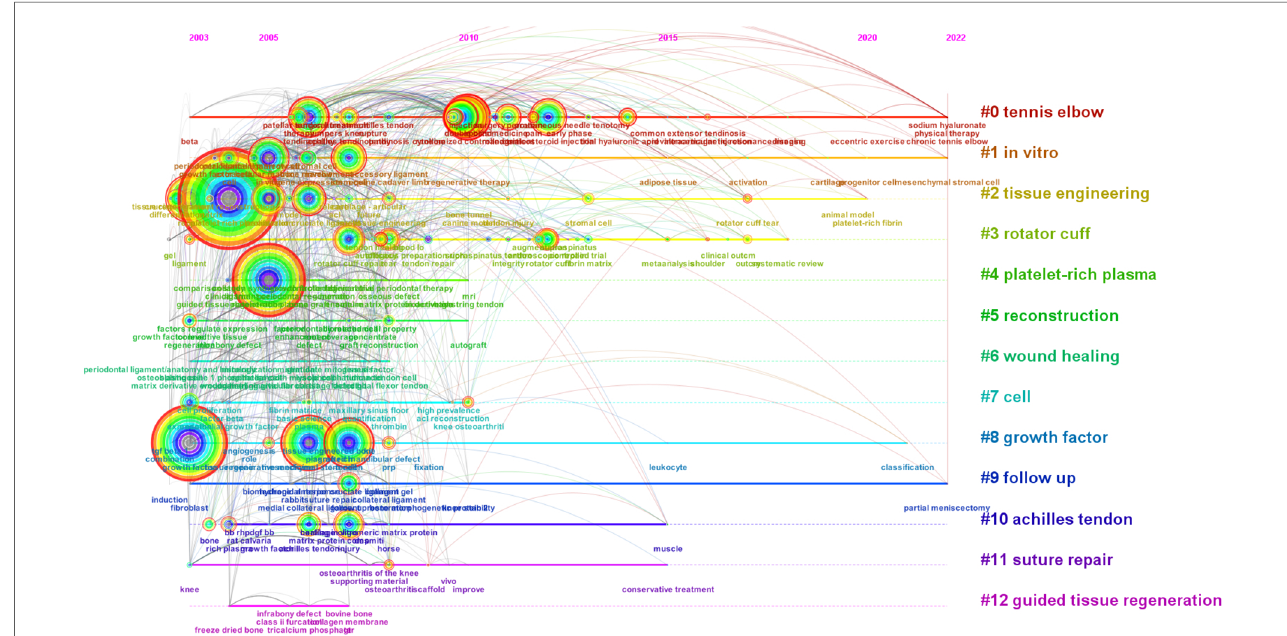
FIGURE 6 Keyword timeline view of using platelet-rich plasma to treat ligament and tendon injuries. Note: The circles in the fi gure represent keywords, and the larger the circle indicates the higher the frequency of the keyword. The dark to light colors represent the years from far to near, the connecting lines represent the links between the keywords, and the thickness of the purple outer circle represents the centrality of the